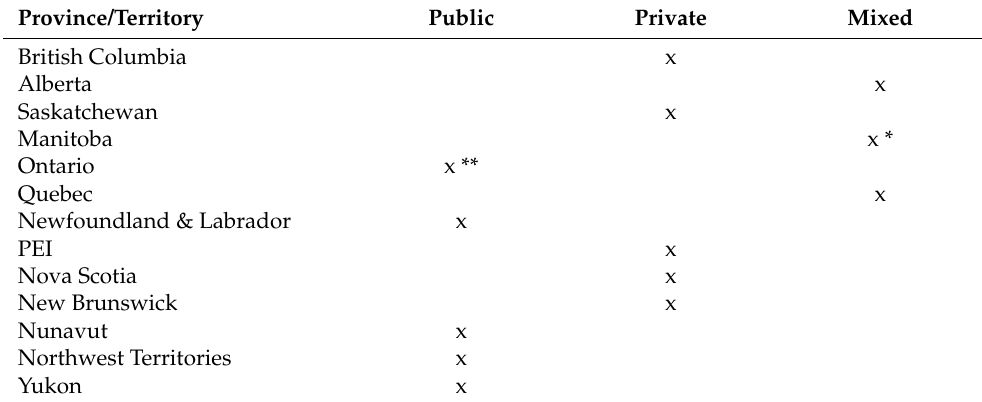
Table 2. Responsibility for Investigations Involving Companion